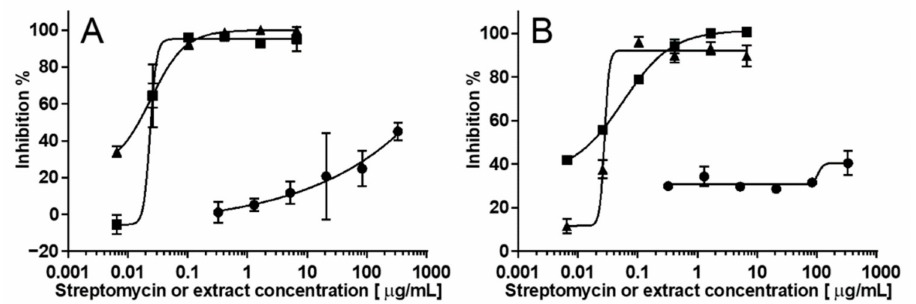
Figure 3. Inhibition curves of streptomycin (square, (cid:4) ), spiked (triangle, (cid:78) ) and un-spiked (cir- cle, • ) crude extracts of the endophytic fungus Alternaria sp. ( A ) and the leaves of J. oxycedrus ( B ) against S. aureus at 37 ◦ C. Measurements performed in triplicates and plotted as mean inhibition (%) ± standard deviations against extract or streptomycin concentration ( µ